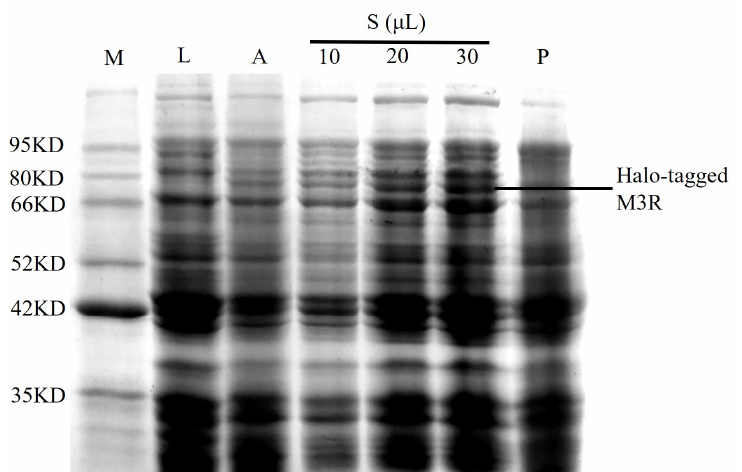
Figure 1. Identi fi cation of M3R in E. coli expressing M3R. Protein marker (M), 10 µL of Luria- Bertani medium (L), 10 µL of autoinduction medium (A), 10 µL, 20 µL, and 30 µL of cell lysate supernatant (S), and 10 µL of cell lysate precipitate (P) were loaded onto a 10% sodium dodecyl sulfate–polyacrylamide gel and stained with Coomassie blue. The corresponding molecular weights of the protein marker are indicated on the left side of the gel.